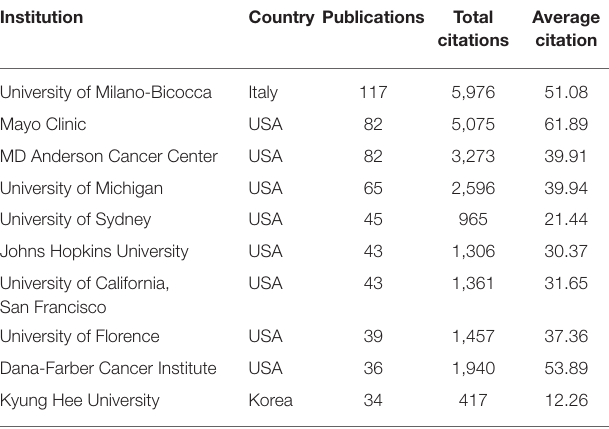
TABLE 1 | The top 10 institution in terms of publications in the chemotherapy-induced peripheral neuropathy (CIPN) field.